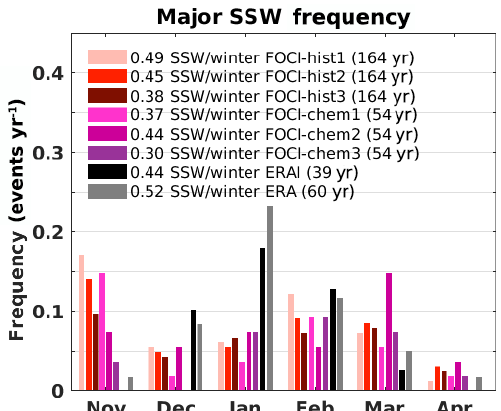
Figure 19. The frequency of major sudden stratospheric warm- ings (SSWs) from the FOCI-hist (1850–2013; red) and FOCI-chem (1960–2013; purple) simulations as well as for ERA-Interim (1979– 2017; black) and a combined ERA40/ERA-Interim dataset (1958– 2017; grey) during NH winter from November to April. The total SSW frequency for the entire winter season is given in the